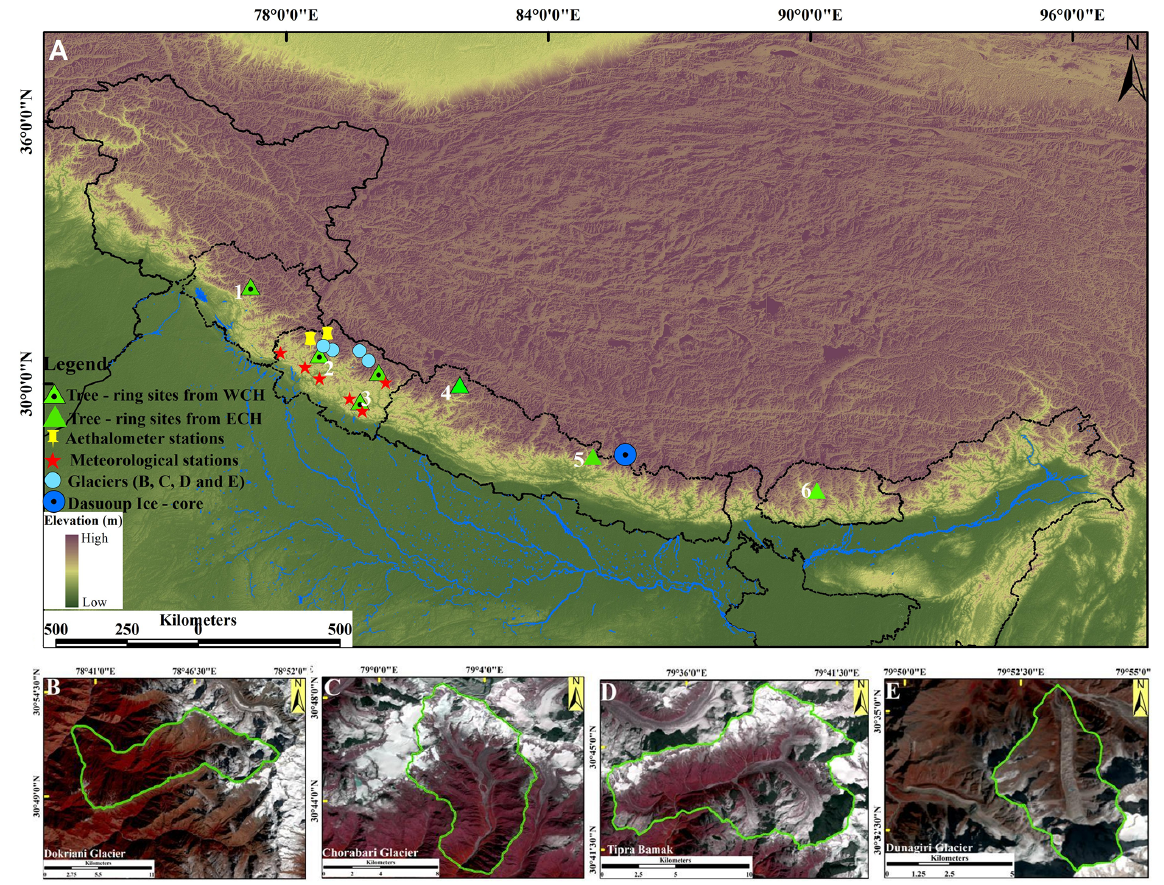
Figure 1. (a) The study region at the transitional climate zone of the western central Himalaya (WCH) showing tree-ring sampling sites, meteorological and aethalometer stations, and four benchmark glaciers of the Uttarakhand Himalaya ( b : Dokriani Glacier; c : Chorabari Glacier; d : Tipra Bamak; e : Dunagiri Glacier). Tree-ring sites from the WCH include (1) Manali (Sano et al., 2017), (2) Uttarakashi (Singh et al., 2019), and (3) Jageshwar (Xu et al., 2018). The Dasuopu ice core site in the eastern part of the central Himalaya (ECH) has been indicated with a blue circle with a dot (Thompson et al., 2000), while tree-ring sites of the ECH are (5) Ganesh (Xu et al., 2018) and (6) Bhutan (Sano et al., 2013). The fourth tree-ring site (Humla; Sano et al., 2012) has been indicated between the WCH and